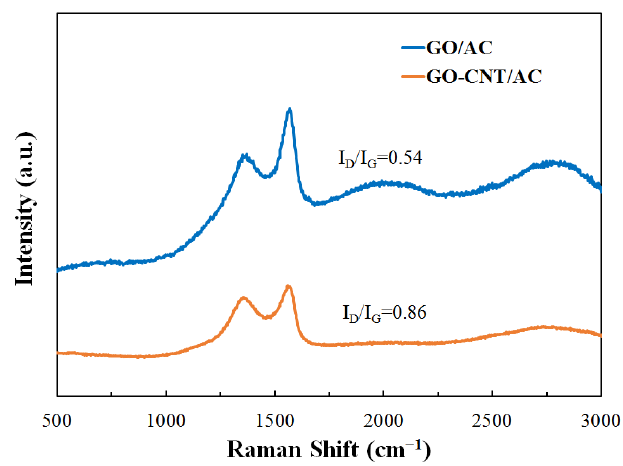
Figure 3. Raman spectra of GO/AC and GO ‐ CNT/AC composites.